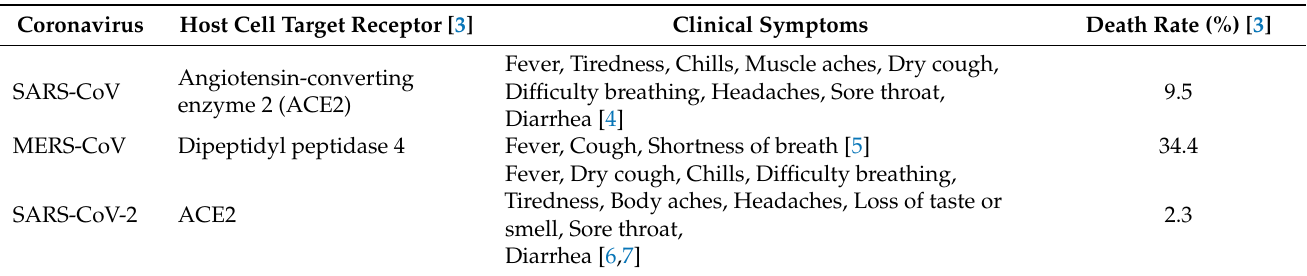
Table 1. Characteristics of severe acute respiratory syndrome-coronavirus (SARS-CoV), Middle East respiratory syndrome-coronavirus (MERS-CoV), and